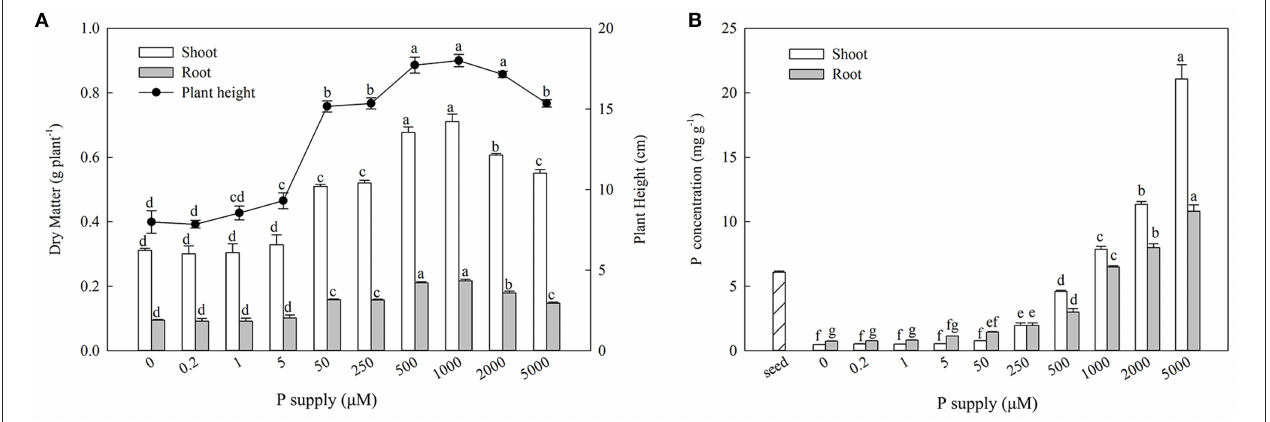
FIGURE 1 | Effect of P supply on biomass, plant height (A) , and organ P concentrations (B) of Zygophyllum xanthoxylum . Data are means ± SE, n = 5; different lowercase letters above bars indicate significant differences ( P < 0.05) between treatments.